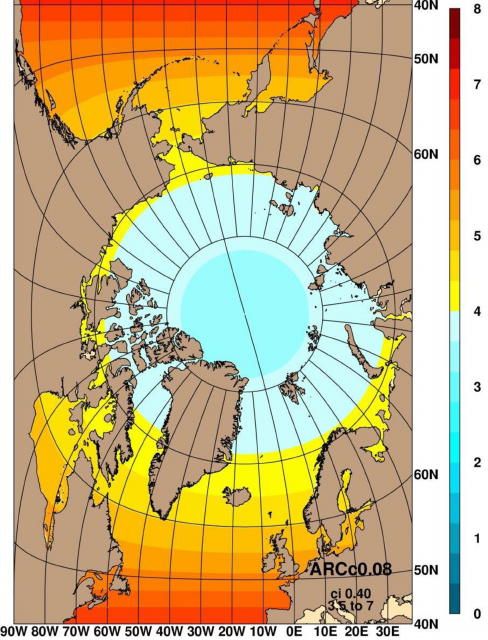
Figure 1. ACNFS and GOFS 3.1 model grid resolution (km) for the Arctic